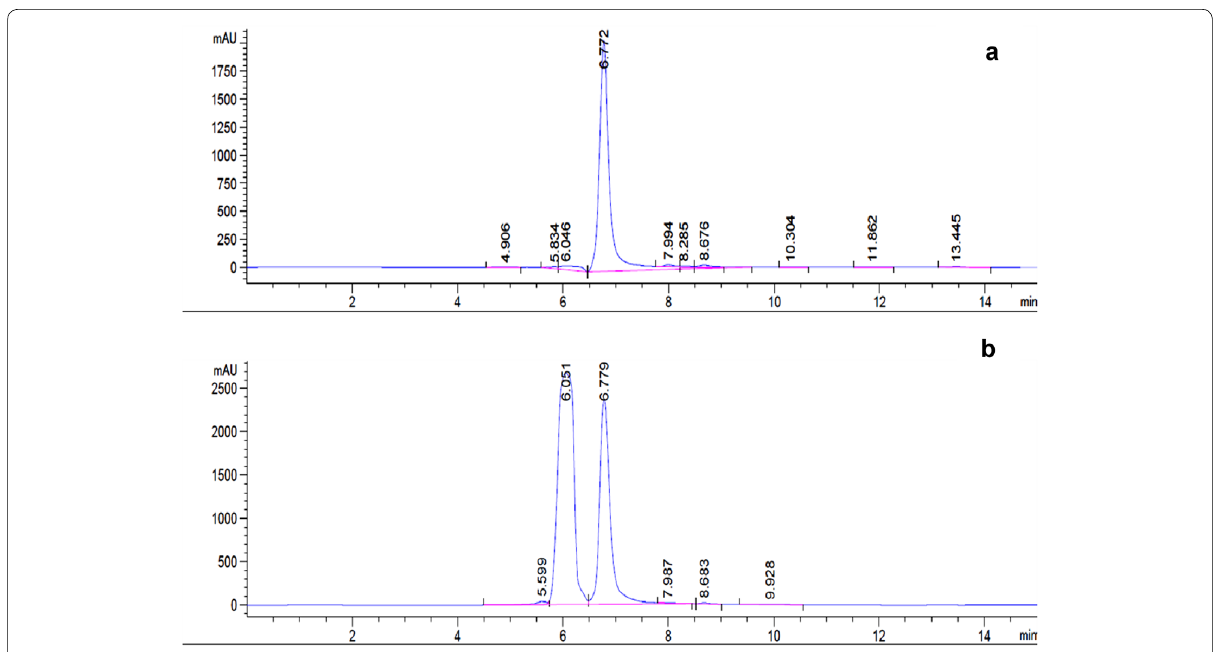
Fig. 4 HPLC profile of a standard IAA, b purified IAA